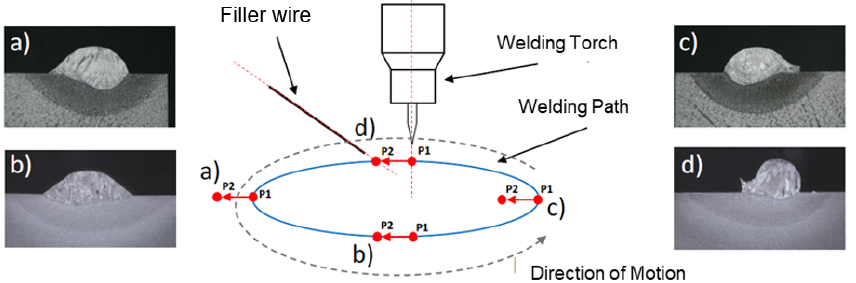
Figure 1. Preliminary tests carried out at the Welding and Joining Institute of RWTH Aachen University to demonstrate direction-dependent weld bead formation with a moving welding torch with eccentric filler wire feeding. Figure ( a , c ) show asymmetric weld seam cross sectional geometry. Figure ( b ) shows an optimal desired geometry using forward feed of the filler wire, whereas figure ( d ) indicates again a geometrical error caused by the backward feed of the filler wire. The red-coloured vector has two point: (P1) is the arc root and (P2) indicates the the filler wire point from where it is supplied into the